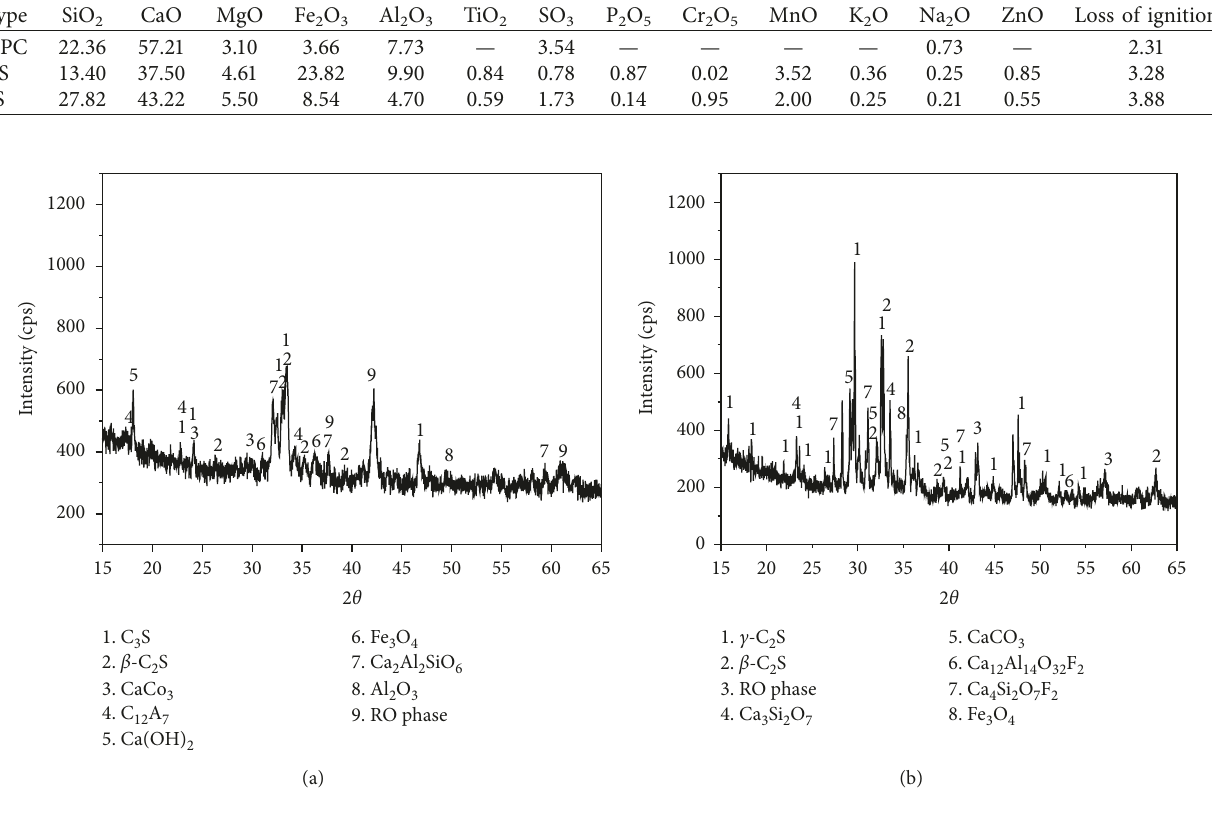
used to prepare the slag pastes at a water-to-slag ratio of 0.3, was obtained, and then, they were casted into plastic cen- trifuge tubes. At the testing age, the hydration of slag pastes was stopped by soaking them in acetone for a specific period.